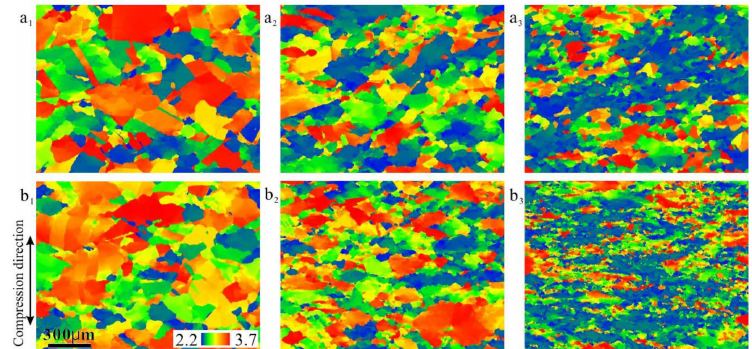
Figure 8. Taylor factors of 18Mn18Cr0.6N steel compressed at different cooling rates: ( a 1 – a 3 ) 0.0125 Ks − 1 ; ( b 1 – b 3 ) 0.025 Ks − 1 . ( a 1 ) and ( b 1 ) are at a strain of 0.2; ( a 2 ) and ( b 2 ) are at a strain of 0.4; ( a 3 ) and ( b 3 ) are at a strain of 0.8. The vertical direction is the compression direction.